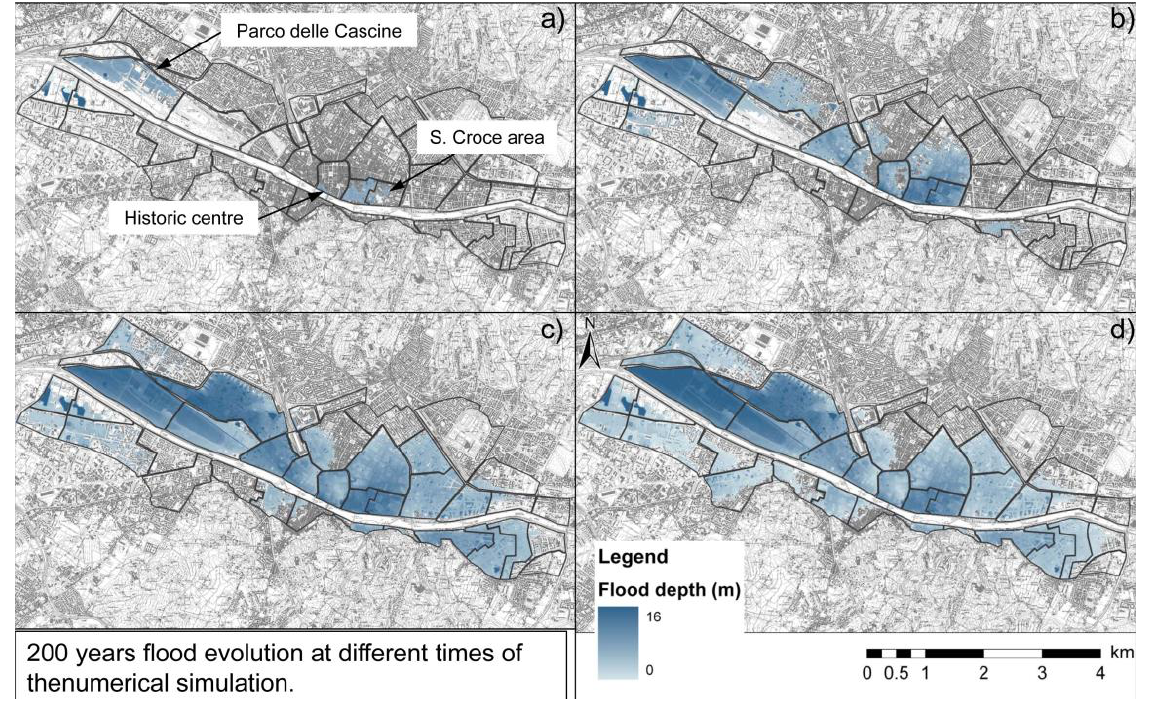
Fig. 6. Water depth in Florence after 16 (a) , 18 (b) , 22 (c) , and 26h (d) from simulation start of the 200yr flood event. Figure 6. Water depth in Florence after 16 hours (a), 18 hours (b), 22 hours (c), 26 hours (d) 2 from simulation start of the 200 years flood event. 3